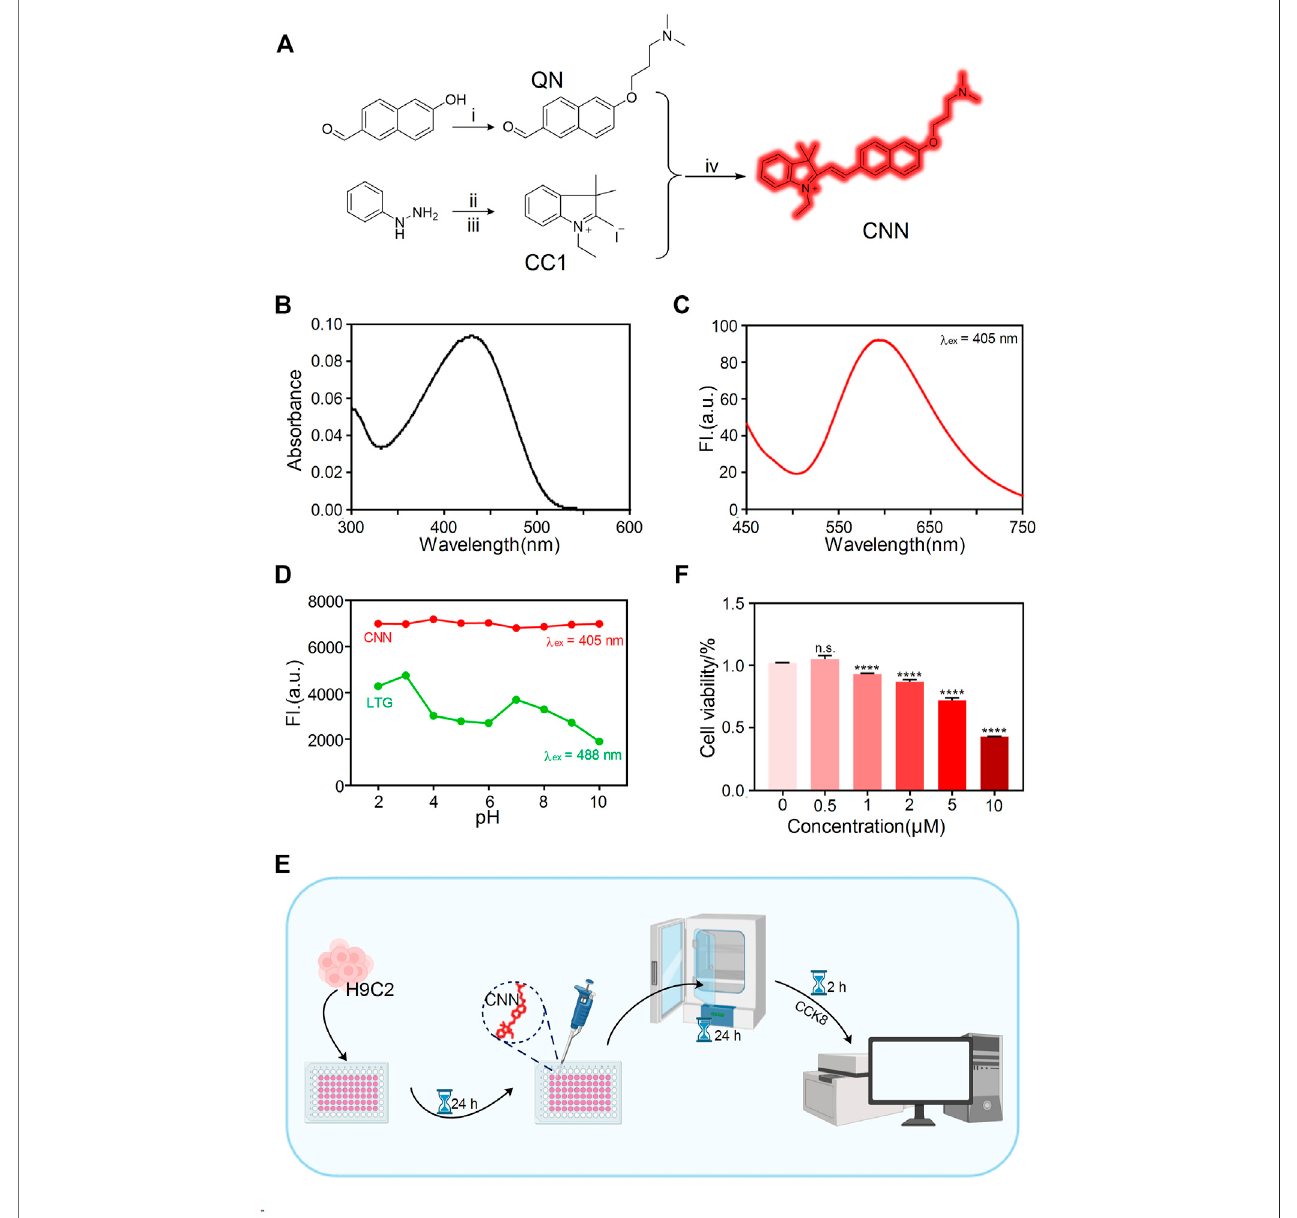
FIGURE 1 | Design and characterization of the biosensor CNN. (A) Synthetic route of probe CNN. 1) 3-Chloro-N, N-dimethylpropan-1-amine, 6-